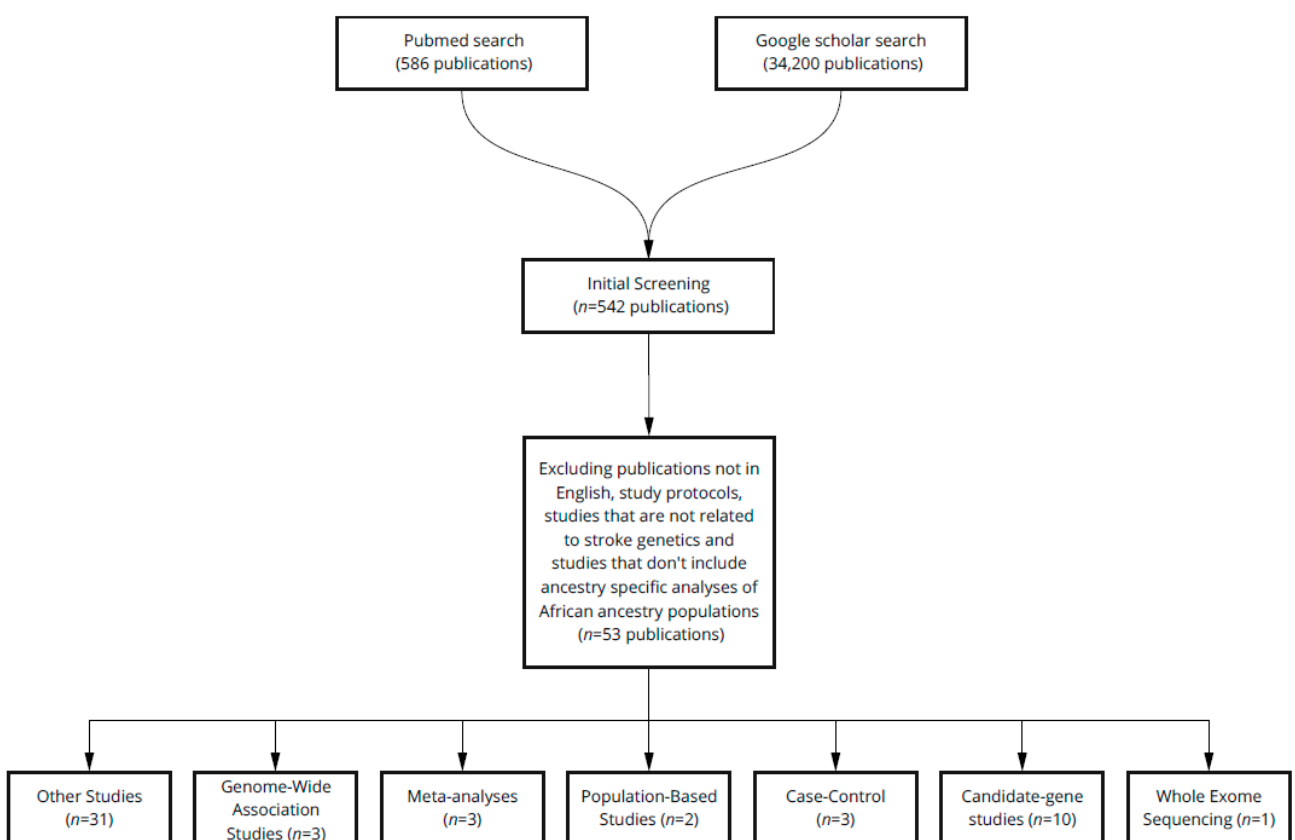
Figure 1. Publication selection process. The number of studies included in each step of the filtering process is stated and the criteria for excluding papers from the review are listed. The final number of studies ( n = 53) is further classified as one of seven different categories depending on study type.